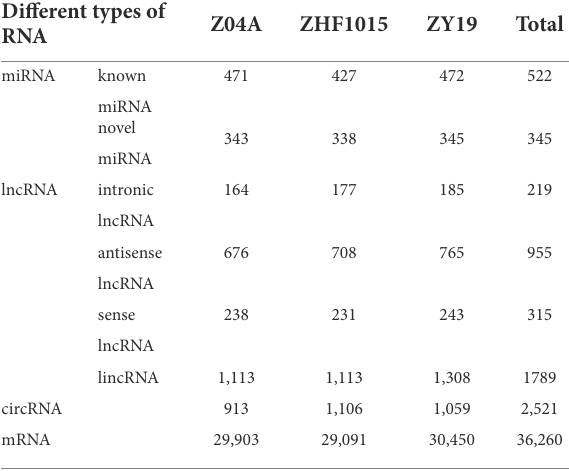
TABLE 1 Number of RNA identified in the inter-subspecific hybrid rice